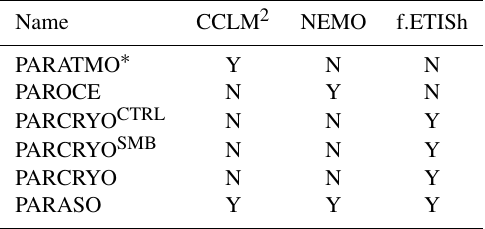
Table 4. List of experiments from which the presented diagnostics are derived. Besides the presence (or lack thereof) of model compo- nents and coupling interfaces, all experiments share the same design and cover the 2000–2001